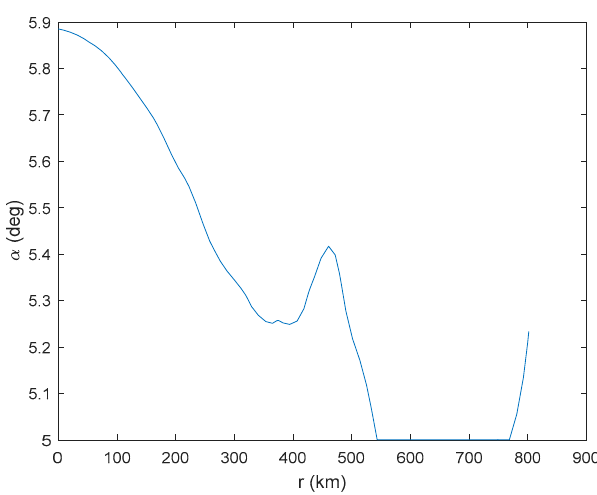
Figure 9. The optimal angle of attack at the initial altitude of 43 km.